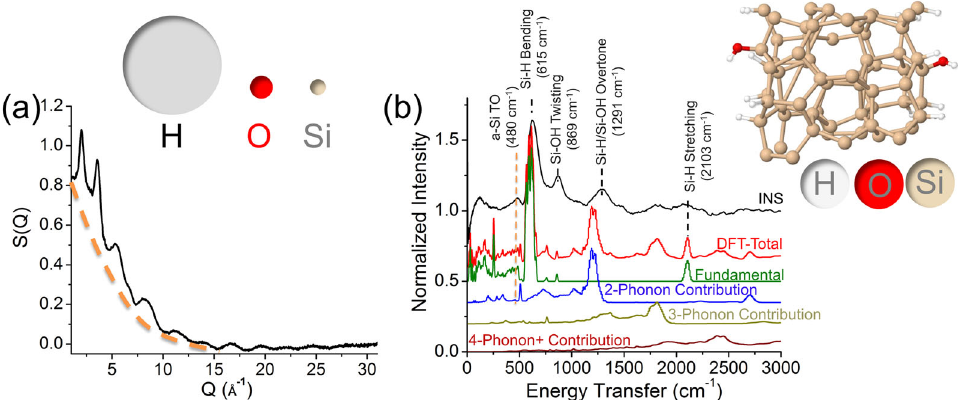
Fig. 6 The neutron scattering plot and inelastic neutron scattering spectrum of a-Si. a Neutron scattering plot of the structure factor, S versus the scattering vector, Q collected from amorphous silicon a-Si under the same sputtering condition to deposit the a-Si thin fi lm. The dashed curve guides the eye as an indication of the background from incoherent scattering. Inset schematically illustrates the relative size of the incoherent scattering cross-section (XS) of proton (80.260), the coherent XS of oxygen (4.232), and the coherent XS of silicon (2.163). b Comparison between the experimental inelastic neutron scattering spectrum of the amorphous silicon a-Si sample and that calculated using DFT based on the atomic conformations shown in the inset image. The calculated total spectrum combines the fundamental vibrational modes and higher order excitations up to 10